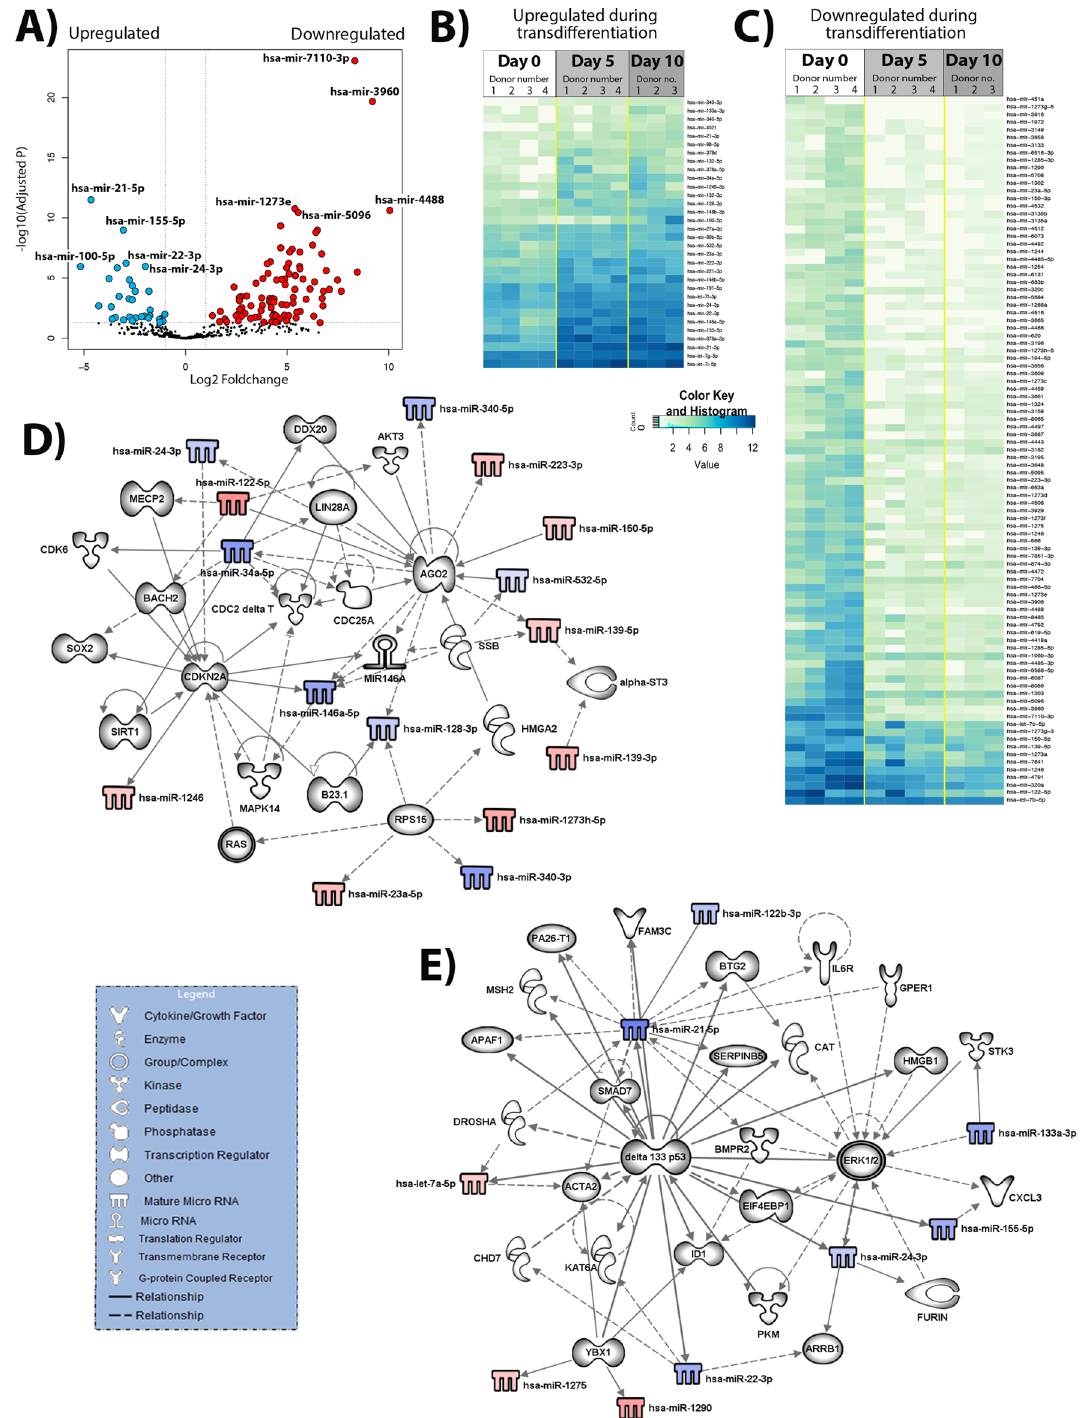
Figure 3. Differential expression of human HSC activation during the perpetuation stage. ( A ) Volcano plot of the comparison between the freshly isolated, quiescent HSC (day 0, n = 4) and fully activated HSC (day 10, n = 3). In blue—differentially under-expressed miRNA in day 0; in red—differently over-expressed miRNA in day 0 (p-adjusted < 0.05 and foldchange > 1). ( B ) Heatmap of the 32 significant under-expressed miRNA in day 0 when compared to day 10, p-adjusted < 0.05. ( C ) Heatmap of the 93 significant miRNA over-expressed in day 0 when compared to day 10, p-adjusted < 0.05. ( D ) and ( E ) Biological networks of differentially expressed miRNA. In blue and red, under and over-expressed miRNA, respectively. Shadowed in grey are molecules related to miRNA, as displayed on the legend. Lines represent different relationships between the molecules and